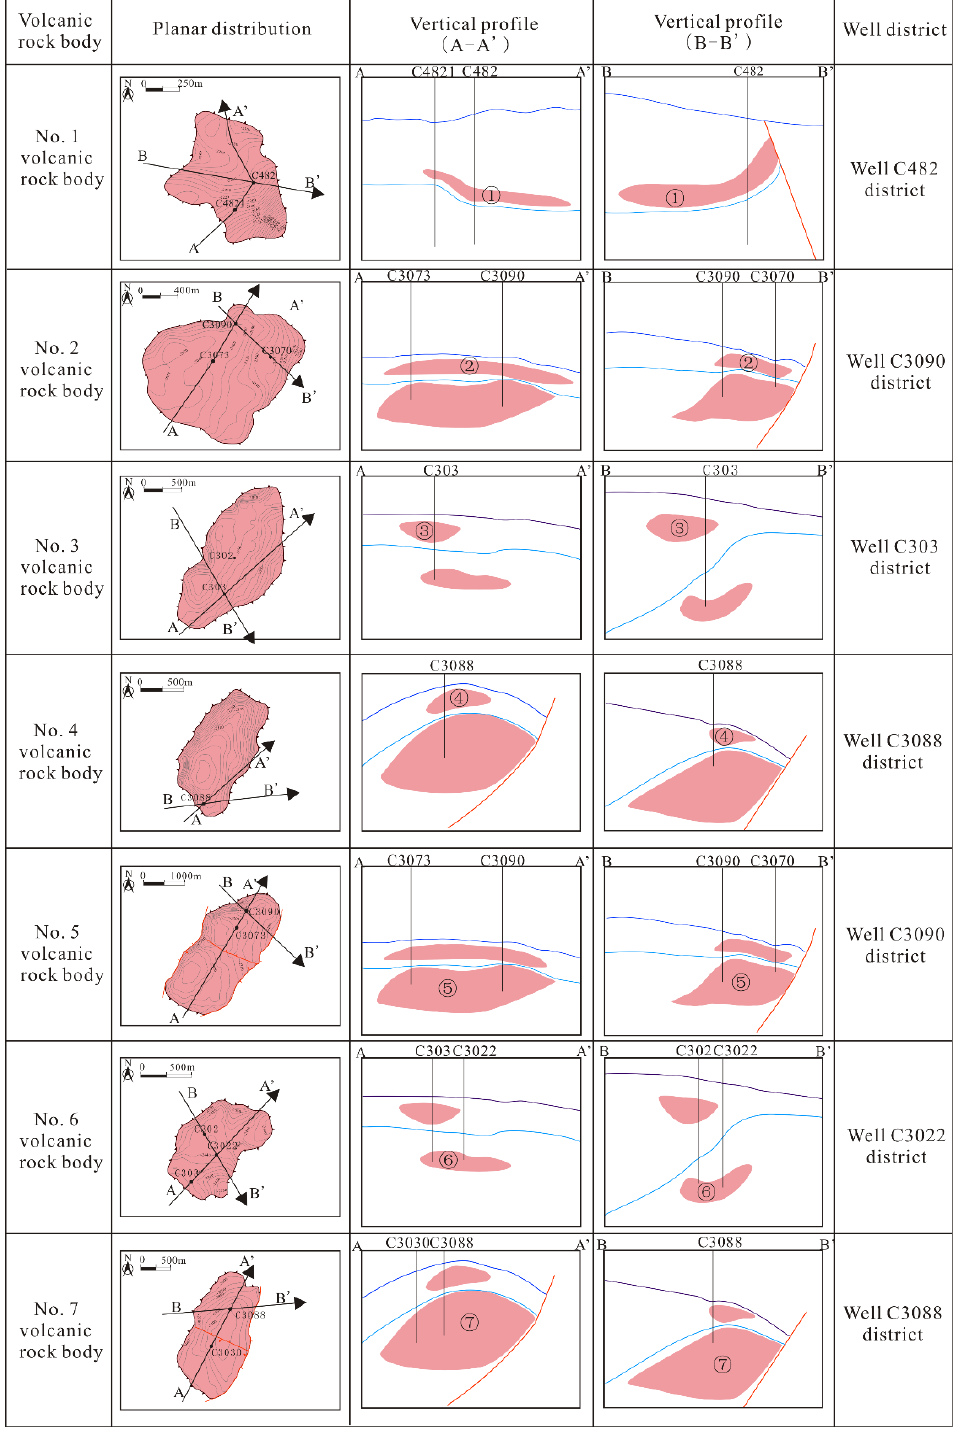
Figure 6. Planar distributions and vertical profile of Carboniferous volcanic rock bodies in the Chepaizi Uplift. ① The number one of the overflow facies volcanic rock body,the trap area is 0.62km 2 ; ② The number two of the overflow facies volcanic rock body, the trap area is 2.08km 2 ; ③ The number three of the overflow facies volcanic rock body, the trap area is 3.5km 2 ; ④ The number four of the overflow facies volcanic rock body, the trap area is 1.3km 2 ; ⑤ The number five of the explosive facies volcanic rock body, the trap area is 4.6km 2 ; ⑥ The number six of the explosive facies volcanic rock body, the trap area is 0.62km 2 ; ⑦ The number seven of the explosive facies volcanic rock body, the trap area is 7.2km 2 .